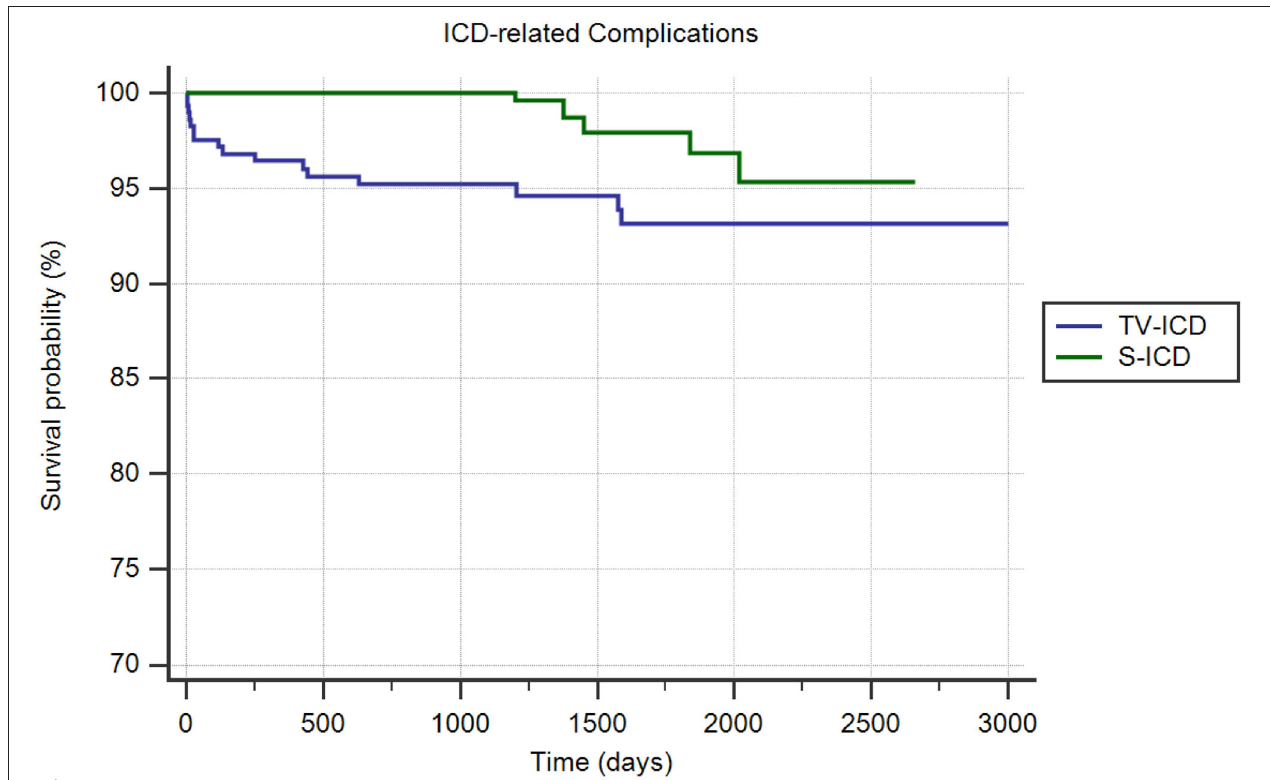
FIGURE 2 | Kaplan-Meier curve comparing survival without ICD related complications among S-ICD vs. TV-ICD